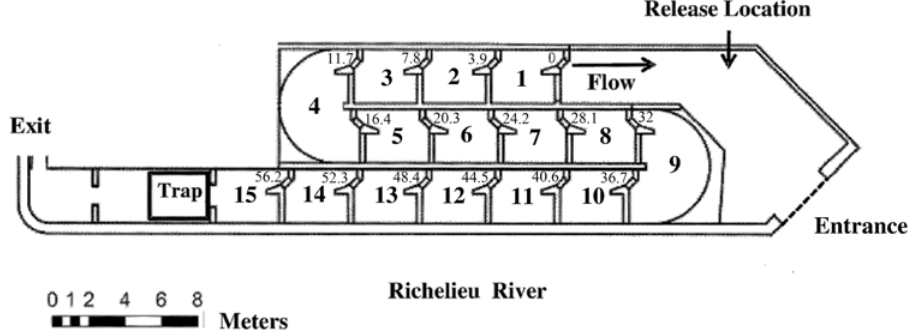
Fig 1. Schematic of the Vianney-Legendre vertical slot fishway on the Richelieu River in Quebec, Canada. Distance metrics, corresponding to locations of PIT antennas, indicate the cumulative minimum transit distance between successive fishway basins (beginning at 0 m). The order of the basin starts from downstream (basin 1) to upstream (basin 15) in accordance with the direction of fish movement.